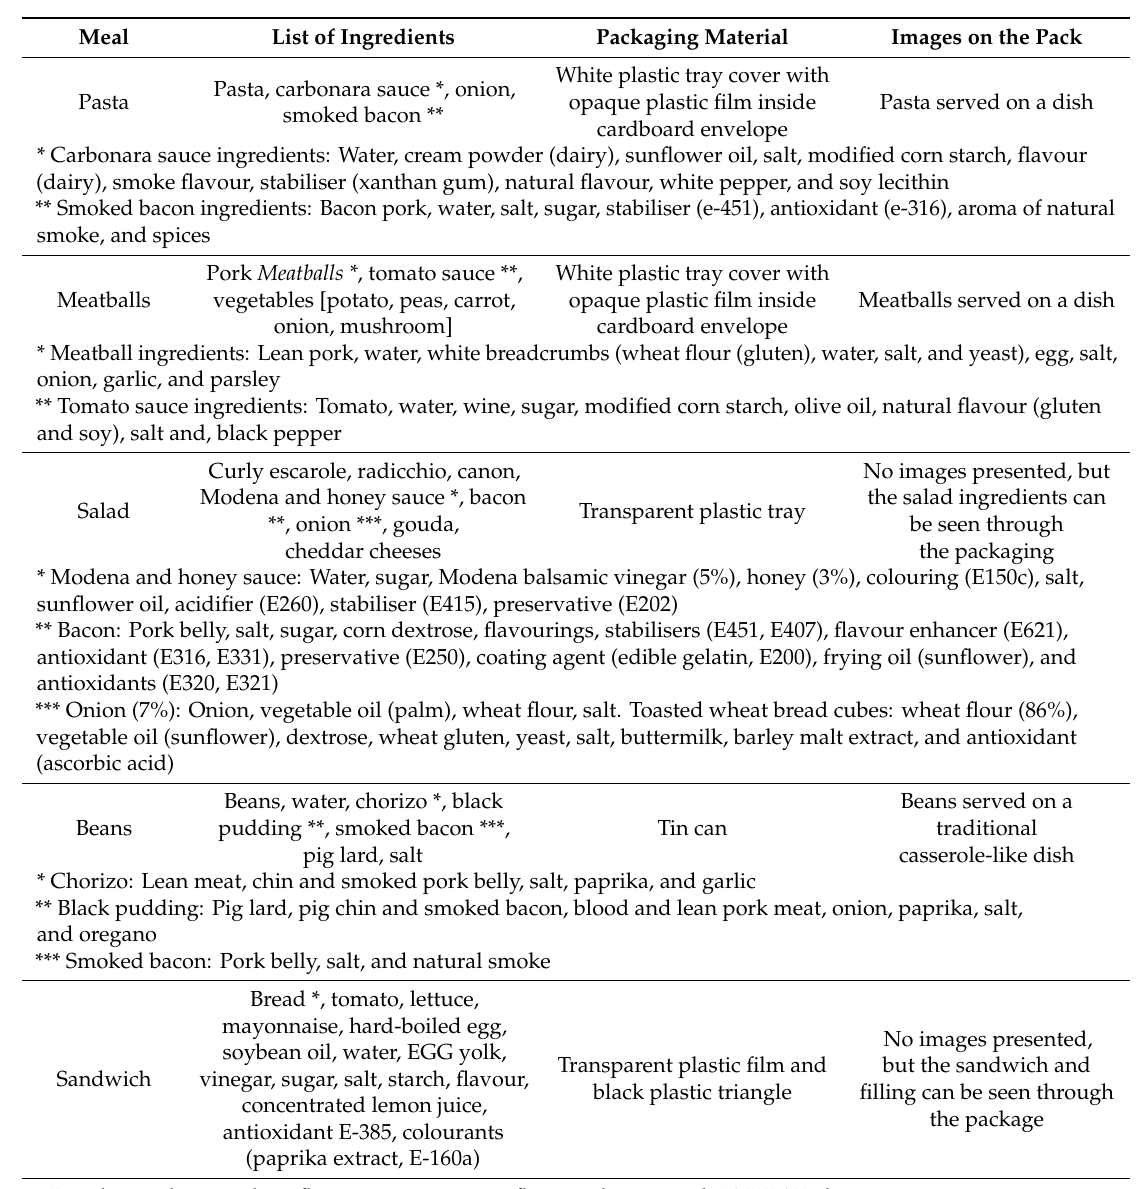
Table 1. List of ingredients and packaging description of the ready-to-eat